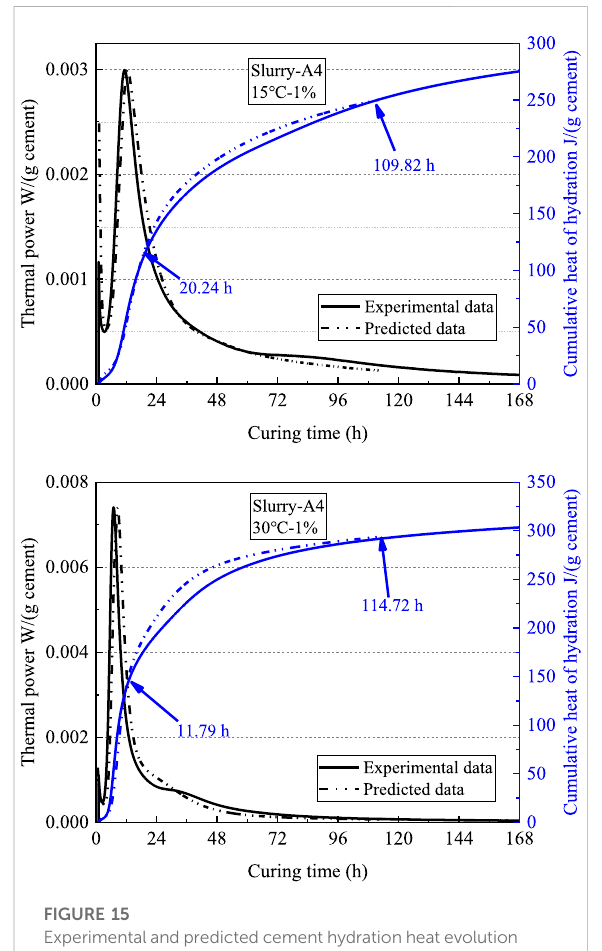
FIGURE 15 Experimental and predicted cement hydration heat evolution under the effect of CaCl 2 for Aksu cement (w/c=0.4).